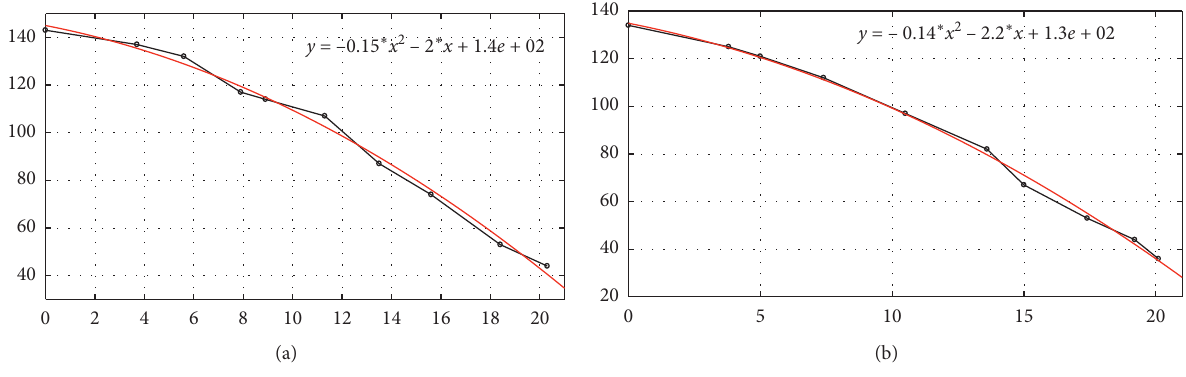
Figure 7: Moisture content-cohesion curve.